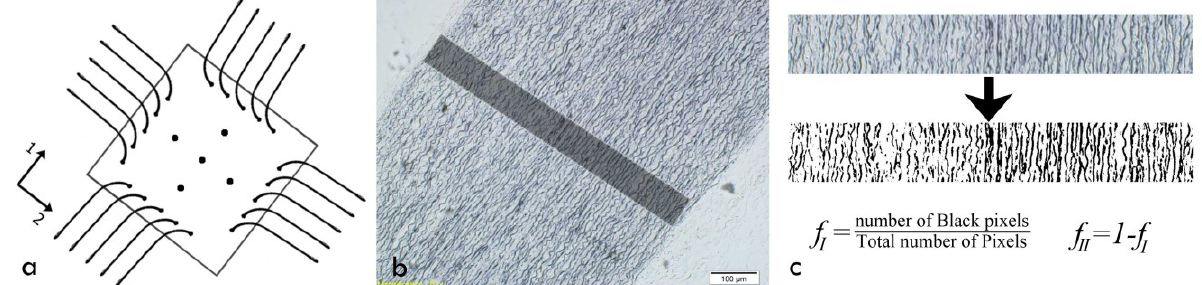
Figure 2. ( a ) A schematic of the sample under biaxial stretch; ( b ) Stained aortic media. Dark regions in this tissue section denote elastic fibers (Layer I), and light colored regions denote interlamellar zones, including collagen bundles, fine elastic fibers and smooth muscle cells (SMCs) (Layer II); ( c ) Volume fraction computation steps, including radial strip extraction, conversion to black and white and, finally, counting the number of pixels of the dark (Layer I) and light (Layer II) areas, as well as finding their proportion regarding the total number of